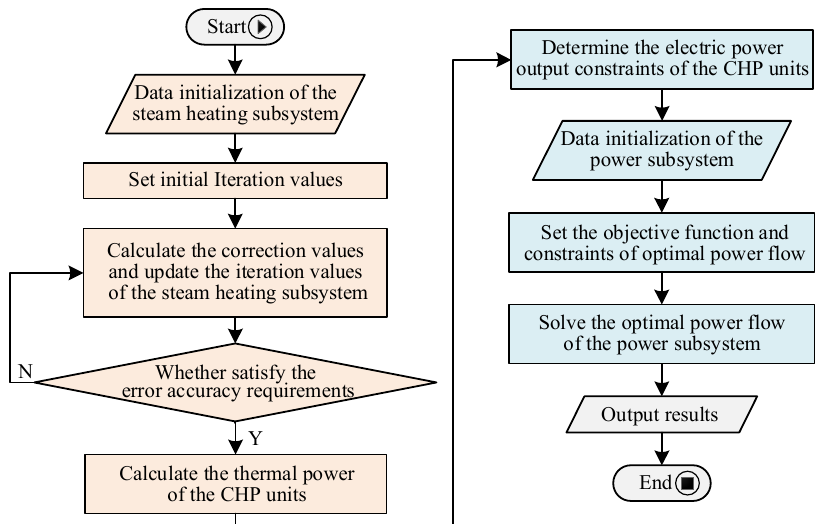
Figure 9. Computation framework of CESS with extraction condensing units.